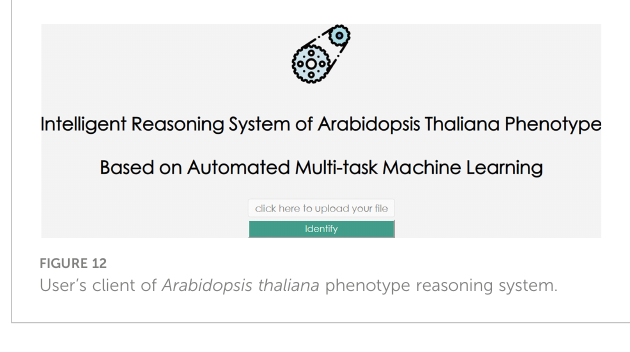
FIGURE 12 User ’ s client of Arabidopsis thaliana phenotype reasoning system.